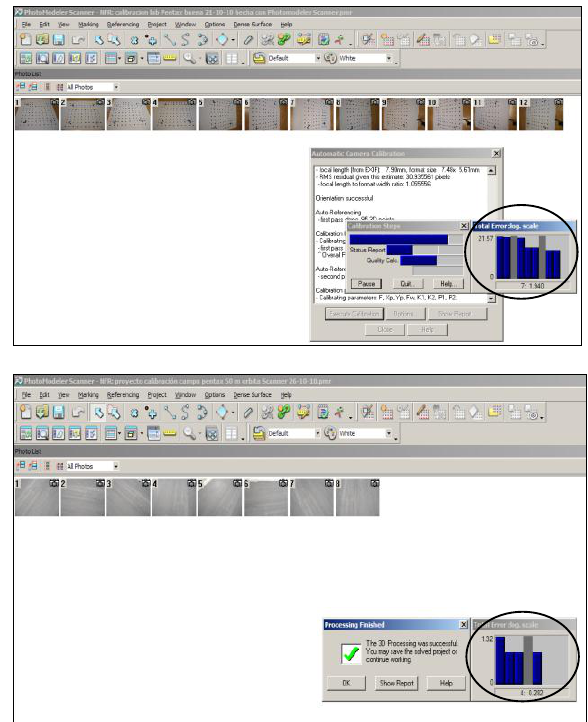
Upper figure shows the processing of the lab calibration and the lower figure shows the field calibration processing. The accumulated error of both processes can be seen representing by the error chart Accuracy of field calibration was also checked comparing the GPS coordinates of the targets with the coordinates obtained with Photomodeler. This software only needs three control points to change from relative to absolute coordinates. For this process the targets number one, two and four were used. The planimetric and the altimetric RMS were calculated. The planimetric RMS was 0.028 m and the altimetric 0.026 m. These small errors point out the accuracy of the